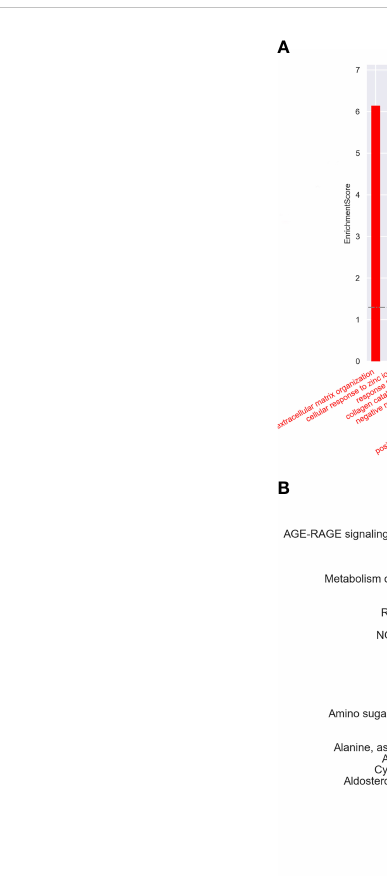
FIGURE 3 GO and KEGG pathway analyses of mRNAs differentially expressed between early-stage and locally advanced GC. (A) The top 10 GO terms in each category corresponding to dysregulated mRNAs. (B) The top 30 KEGG pathways enriched in mRNAs dysregulated in locally advanced GC.